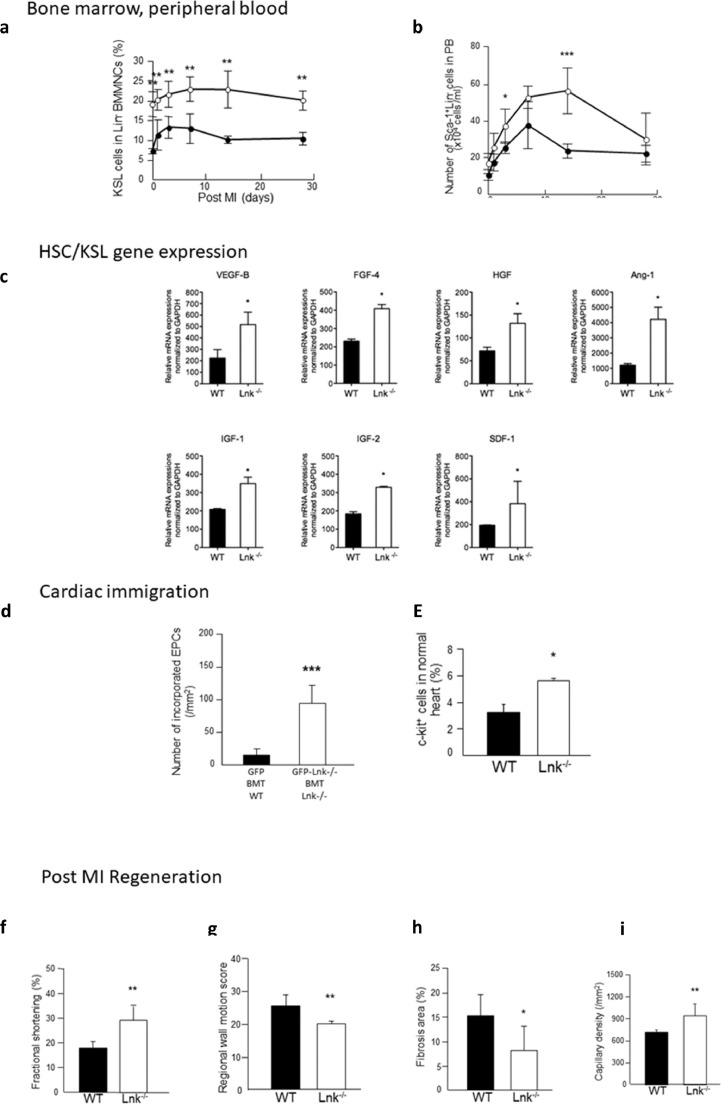
Experimental SH2B3 mouse MI-modelBone marrow, peripheral blood kinetics of KSL cells in BM and SL cells in PB in WT vs. SH2B3/LNK−/- mice following MI. SH2B3/LNK−/− leads to increased EPC in bone marrow and circulation post MI a: Percent of KSL cells in Lin− BMMNCs before and after MI significantly increased in SH2B3/LNK−/− mice (open circles) compared with WT mice (closed circles). Two-way ANOVA followed by Tukey's multiple comparisons test **, p<0.01 vs. WT (n=3-4). b: Number of Sca-1+/Lin− (SL) cells in PB in SH2B3/LNK−/− mice (open circles) and WT mice (closed circles) before (Pre) and one day, 3, 7, 14, and 28 days after MI. Two-way ANOVA followed by Tukey's multiple comparisons test *, p<0.05 and ***, p<0.01 vs. WT (n=3-4).c: HSC/KSL gene expression - Growth Factor and Chemokine mRNA expressions in WT BM-KSL cells vs. SH2B3/LNK−/− BM-KSL cells. KSL cells were sorted from freshly isolated BMMNCs by FACS, and were analysed the expressions of VEGF-B, FGF-4, HGF, Ang-1, IGF-1, IGF-2, and SDF-1 by quantitative real-time RT-PCR. Each relative mRNA expression was normalized to GAPDH and compared between WT BM-KSL cells (solid bar) and SH2B3/LNK−/− BM-KSL cells (open bar). Bonferroni post hoc test *, p<0.05. (n=3).d: Effect of SH2B3/LNK gene deficiency on recruitment of BM-derived progenitors to ischemic myocardium. d: Double fluorescent immunostaining for GFP (green) and isolectin B4 (red) in heart sections in WT mice transplanted with GFP+ BM and in SH2B3/LNK−/− mice transplanted with GFP+- SH2B3/LNK−/− BM 7 days following MI. Number of recruited BM-derived cells into vasculature in ischemic myocardium 28 days following MI were counted and averaged. Mann-Whitney comparison test **, p<0.01 and ***, p<0.001 vs. WT mice transplanted with GFP BM. (n=3).e: Assessment for proliferation activity in CSCs/CPCs and cardiomyocytes in ischemic myocardium. Double fluorescent immunostaining for BrdU (red) and c-KIT (green) in heart sections in WT mice and in SH2B3/LNK−/− mice 7 days following MI. Number of BrdU+/c-KIT+ cells in ischemic myocardium 7 days following MI were counted and averaged. Mann-Whitney comparison test *, p<0.05 vs. WT mice (WT: n=4 and SH2B3/LNK−/−: n=3).f-i: Post MI regeneration: physiological and histological assessment for LV function in WT vs. SH2B3/LNK−/- mice following MI. M-mode echocardiography in WT mice and SH2B3/LNK−/− mice 28 days following MI. Fractional shortening (f) and regional wall motion score (g) were significantly great in SH2B3/LNK−/− mice than that in WT mice. Hemodynamic study using a micro-tip catheter in WT mice and SH2B3/LNK−/− mice 28 days following MI. +dP/dt, -dP/dt and EDP were significantly preserved in SH2B3/LNK−/− mice than those in WT mice. Mann-Whitney comparison test *, p<0.05 and **, p<0.01 vs. WT. (n=11) (+dP/dt: WT, 5,942.1±823.7 vs. SH2B3/LNK−/−, 8,901.6±1,147.9 mmHg/sec, p<0.01; -dP/dt: WT, -4,675.9±615.9 vs. SH2B3/LNK−/−, -6,201.4±875.4 mmHg/sec, p<0.01; EDP: WT, 8.6±2.1 vs. SH2B3/LNK−/−, 4.4±1.2 mmHg, p<0.05) (h) Representative Masson's trichrome stained heart sections in WT mice and SH2B3/LNK−/− mice 28 days following MI. Percent of fibrosis area in entire LV area on cross-sections. Histological analysis was performed on day 28 post MI. The percentage of fibrosis area was less in SH2B3/LNK−/− mice than WT mice (WT, 15.2±4.3 vs. SH2B3/LNK−/−, 8.0±5.0 %, p<0.05). Fibrosis area was significantly reduced in SH2B3/LNK−/− mice compared with WT mice. Bonferroni post hoc test * p<0,05 vs. WT. (WT: n=6 and SH2B3/LNK−/−: n=10) (i) Immunostaining for isolectin B4 (brown) in WT and SH2B3/LNK−/− mice 28 days following MI. Capillary density in ischemic border zone in infarcted myocardium of WT mice and SH2B3/LNK−/− mice. Bonferroni post hoc test **, p<0.01 vs. WT. (WT: n=5 and SH2B3/LNK−/−: n=9) capillary density in infarction border zone was significantly greater in SH2B3/LNK−/− mice than WT mice (WT, 713±28 vs. SH2B3/LNK−/−, 937±157/mm2, p<0.01). On the other hand, there was no significant difference in LV function and capillary density between WT mice and SH2B3/LNK−/− mice without ischemic injury.j: Pearson correlation analysis between the mouse infarction model (SH2B3/LNK -/−vs. WT) and human phase 3 PERFECT trial (ΔLVEF Responder vs. Non-responder). The human ΔLVEF response is highlighted for an improved visual analysis of important correlations. The color scale, ranging from 1 to -1 in the upper panel (blue to red), represents the correlation between the different factors. The size of the dots represents the significance (p<0.01, p<0.05, and p>0.05; Pearson correlation) of the respective correlation. Comparison of peripheral blood (PB) circulating cells and biomarkers between mice (purple) and human (serum) (black) (For interpretation of the references to color in this figure legend, the reader is referred to the web version of this article.).